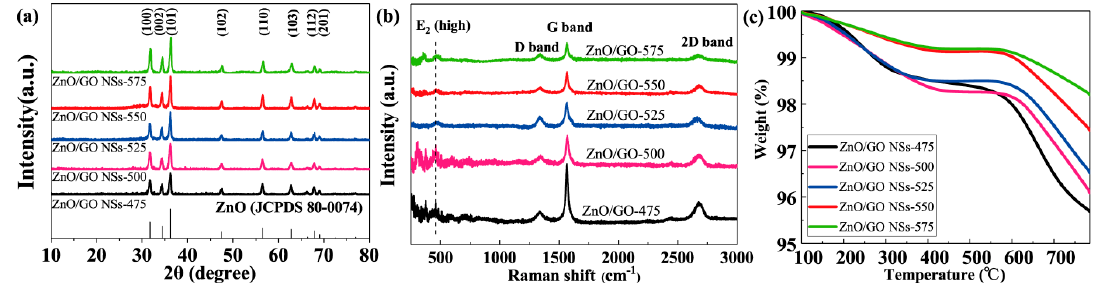
Figure 1. ( a ) XRD patterns of ZnO/GO NSs-T; ( b ) Raman spectra of ZnO/GO NSs-T; ( c ) TGA curves of ZnO/GO NSs-T.